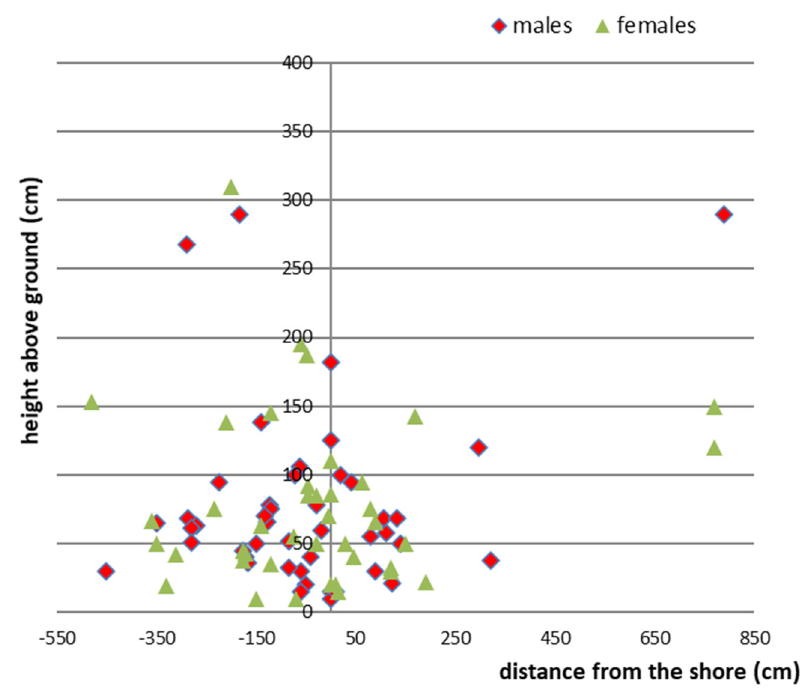
Figure 7. Position of exuviae of Cordulegaster heros in riparian parts of the habitat (x-axes: ( − ) left bank, (+) right bank).